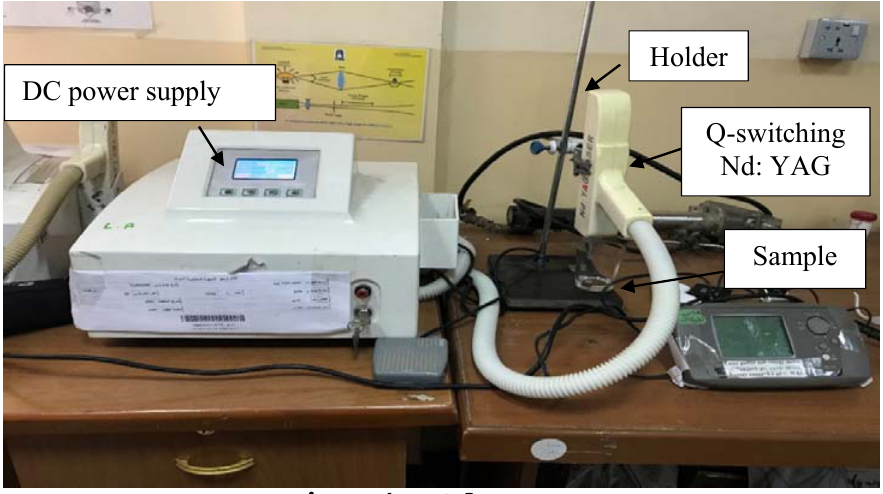
Fig.1 : Nd: YAG laser system.